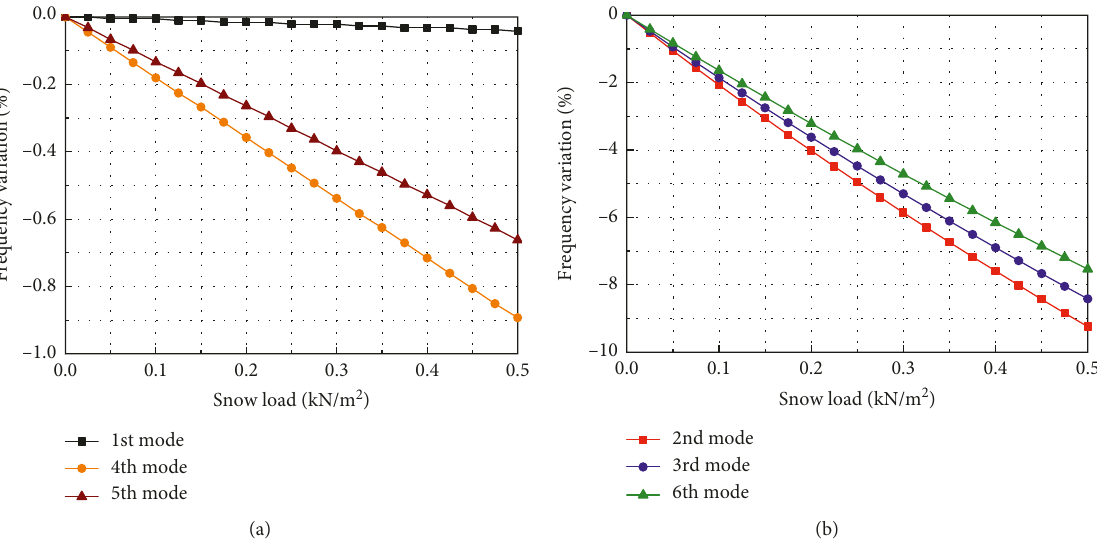
Figure 22: Frequency variations under uniformly distributed snow load: (a) the 1st, 4th, and 5th modes; and (b) the 2nd, 3rd, and 6th